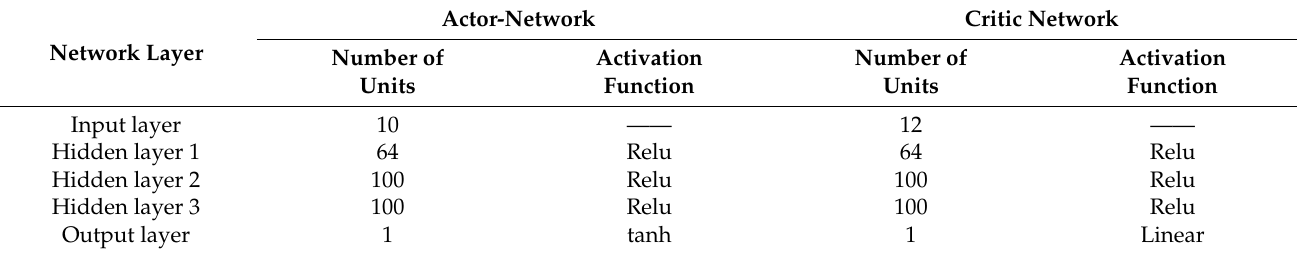
Table 3. Network structure. Table 4. Training hyperparameters.